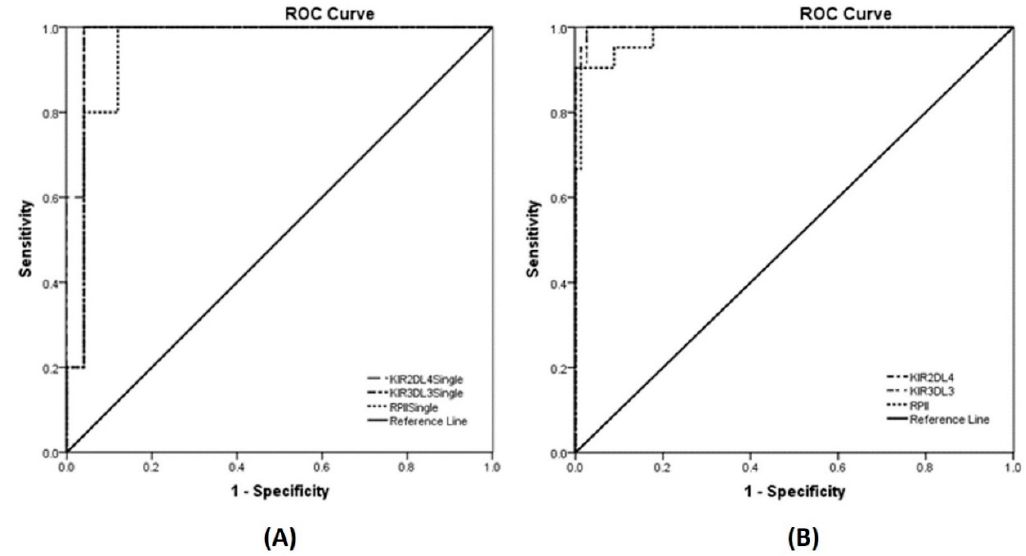
Figure 3. ROC analyses of KIR gene and reference gene expressions in 100 healthy donors were shown. ( A ) ROC curve of the singleplex qRT-PCR showed AUC value for KIR2DL4 and KIR3DL3 were 0.984 and 0.968, respectively ( p < 0.001) and for RPII reference was 0.952 ( p < 0.002); ( B ) ROC curve of the multiplex qRT-PCR, AUC value for KIR2DL4 and KIR3DL3 were 0.998 ( p < 0.001) and for RPII reference was 0.984 ( p < 0.001). ROC—receiver-operating characteristic; AUC—area under the ROC curve. Table 3. Assessment index of the KIR gene expressions in healthy donors based on ROC analysis results.